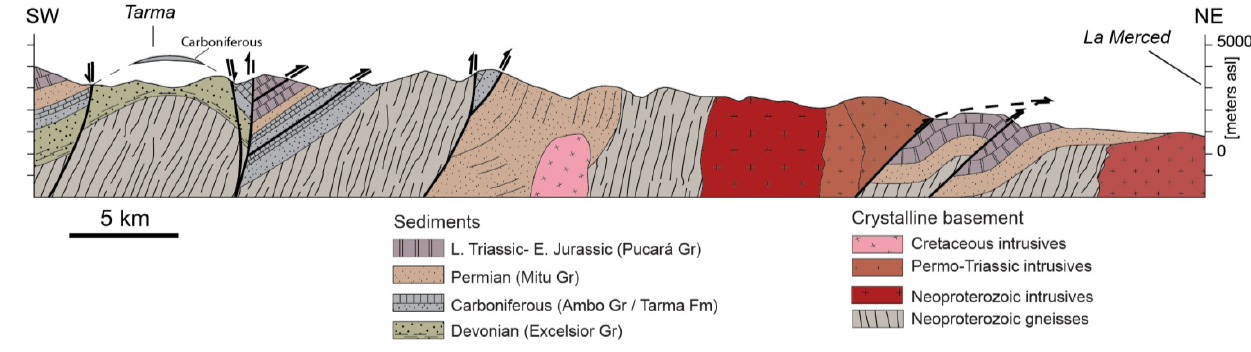
Figure 12. Structural style in the eastern part of the Eastern Cordillera as observed in the valley flanks of Rio Perené between Tarma and la Merced (see Figure 7 for